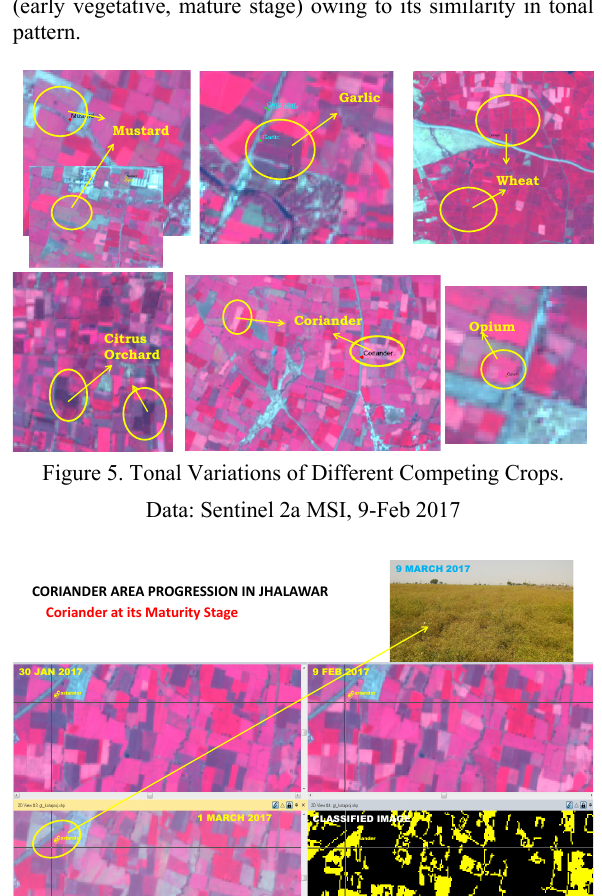
Figure 8. Mean spectral profile of different crops on Sentinel 2A MSI data of 9 th February The temporal profiles of the crop classes as shown in Figure 9 on the other hand showed an increase in distinguishability compared to the spectral profiles based on a single image. Three classes of coriander was identified which represents three stages (vegetative, flowering and maturity) present at a time. It was clearly seen that there was a mixing with one stage of coriander with the mustard in the month of February but in the month of March both gets separated. Figure 9. Temporal spectral profiles of different crops showing mean and standard